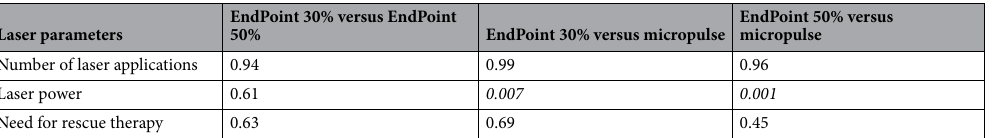
Table 3. Adjusted p-values for comparisons of number of laser applications, power at different time points and need for rescue therapy (injections) in eyes with diabetic macular edema among three treatment groups. Statistically significant values are in italics